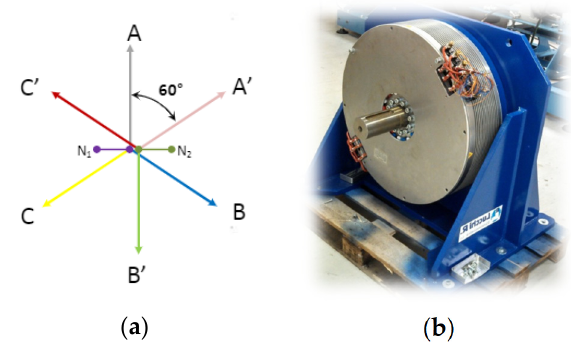
Figure 1. ( a ) Stator Winding configurations; ( b ) 6P-AFPMSM.